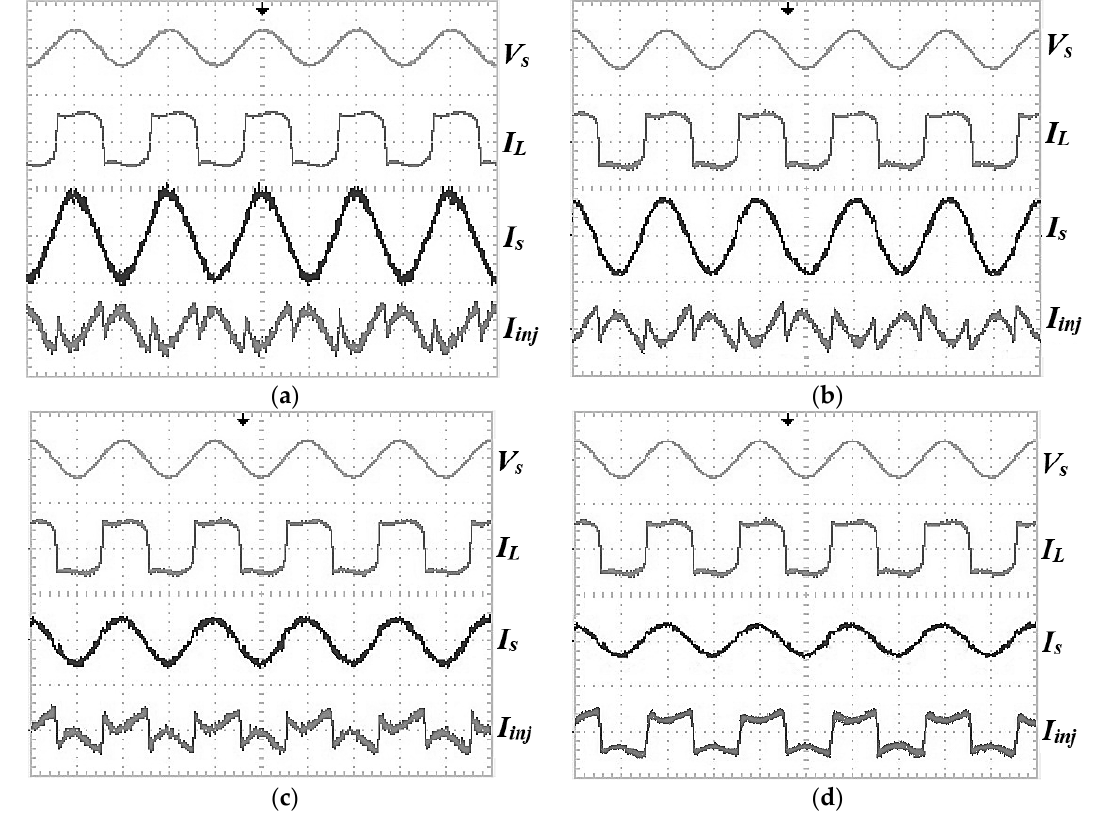
Figure 15. Experimental results which cover source voltage V s (200 A/div), load current I L (5 A/div), injection current I inj (5 A/div), and source current I s (5 A/div) using the Simpler ADALINE current harmonics extraction algorithm for ( a ) 0 W/m 2 , ( b ) 200 W/m 2 , ( c ) 600 W/m 2 , and ( d ) 1000 W/m 2 .